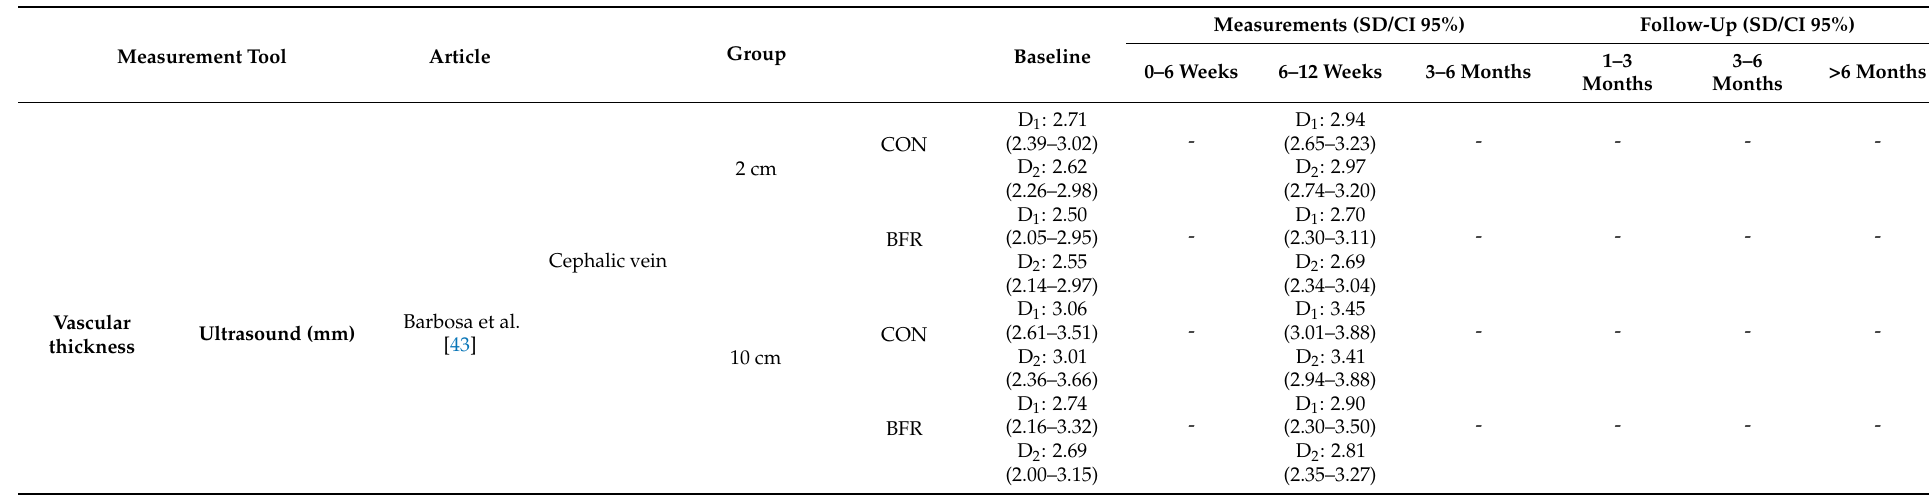
Table 5. Blood/cardiocirculatory